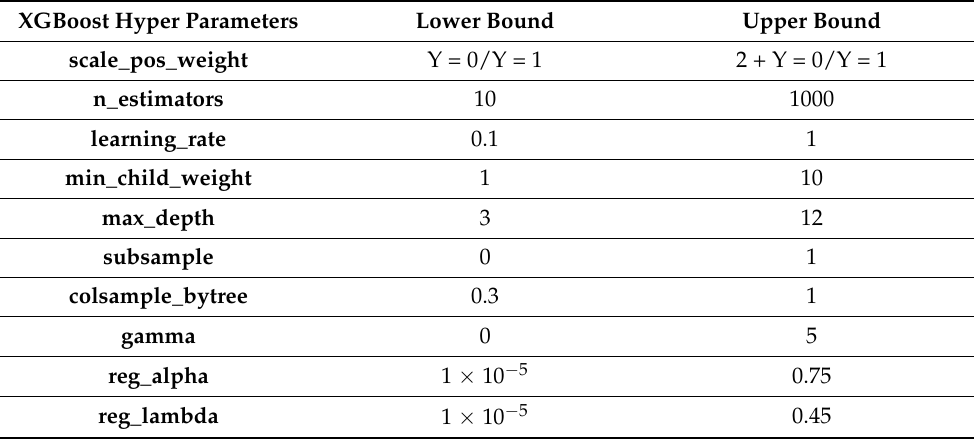
Table A6. Hyperparamter bounds for Bayesian